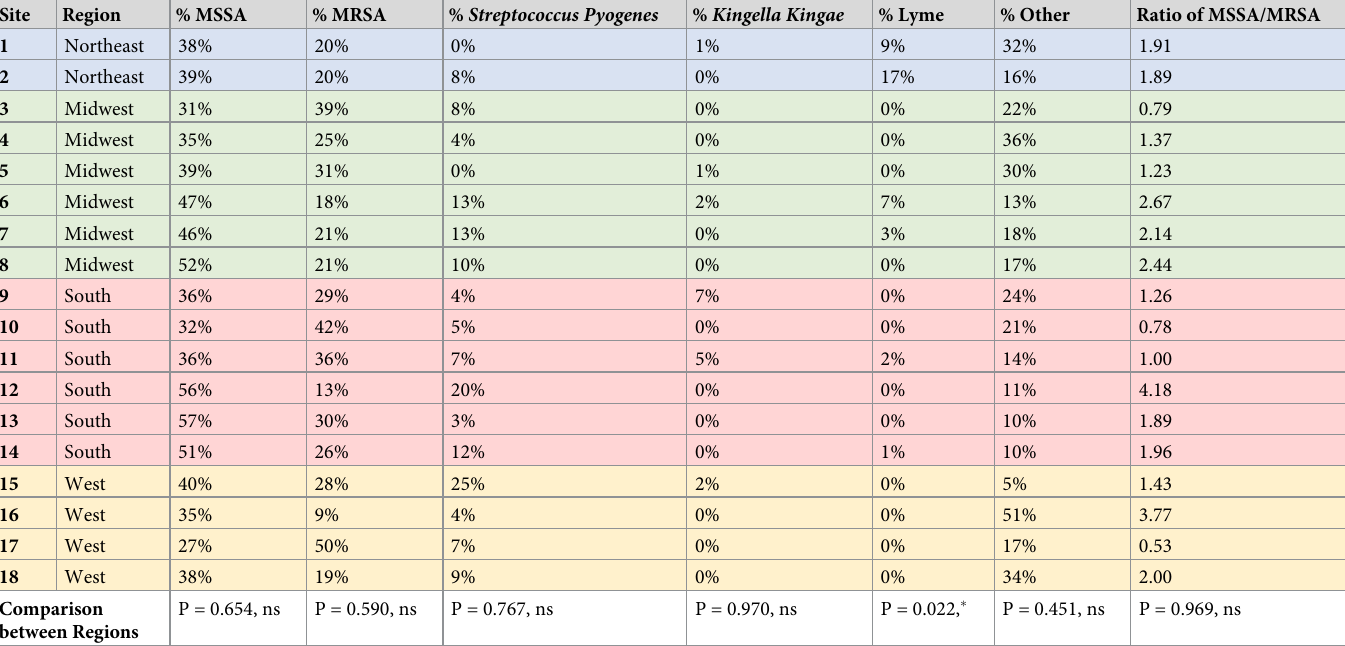
Table 2. Annual percent incidence of causative pathogen proportions per